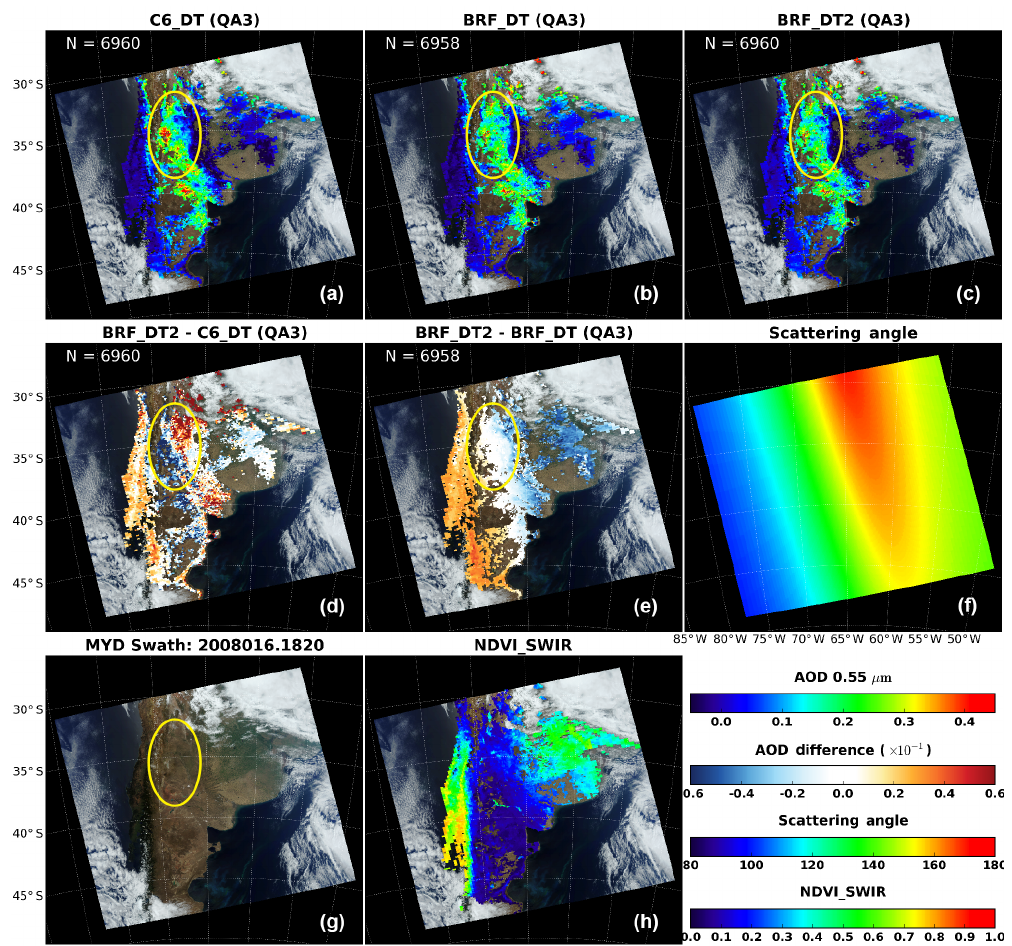
Figure 6. AOD over Argentina. (a–c) show the AOD retrieved by the C6_DT, BRF_DT and BRF_DT2 algorithms. AOD with QA = 3 was labeled as QA3. (d) and (e) show the AOD difference between DT algorithms. (f–h) show the MODIS scattering angle, the MODIS RGB “true color” and NDVI SWIR . The MODIS RGB image is obtained through combination of MODIS channels 1, 4 and 3.